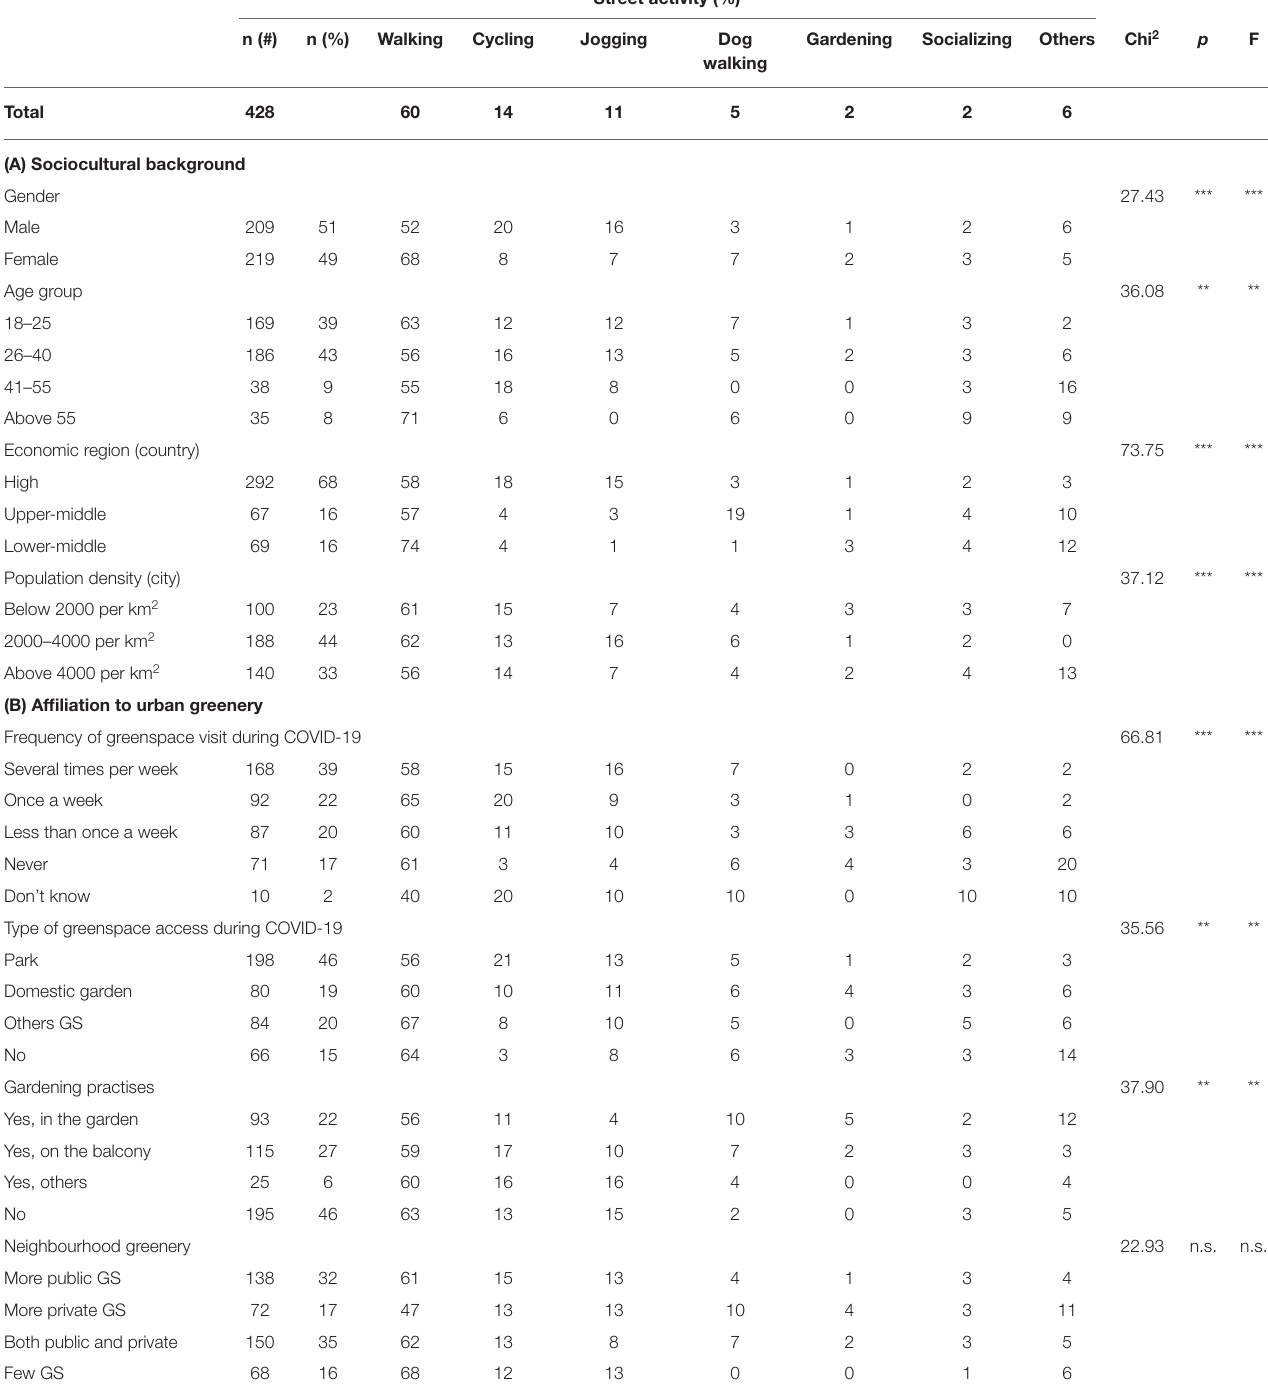
TABLE 1 | Streetscape activities of respondents ( N = 428) during the first wave of partial and complete COVID-19 lockdowns, in relation to (A) their sociocultural background and (B) their affiliation to urban